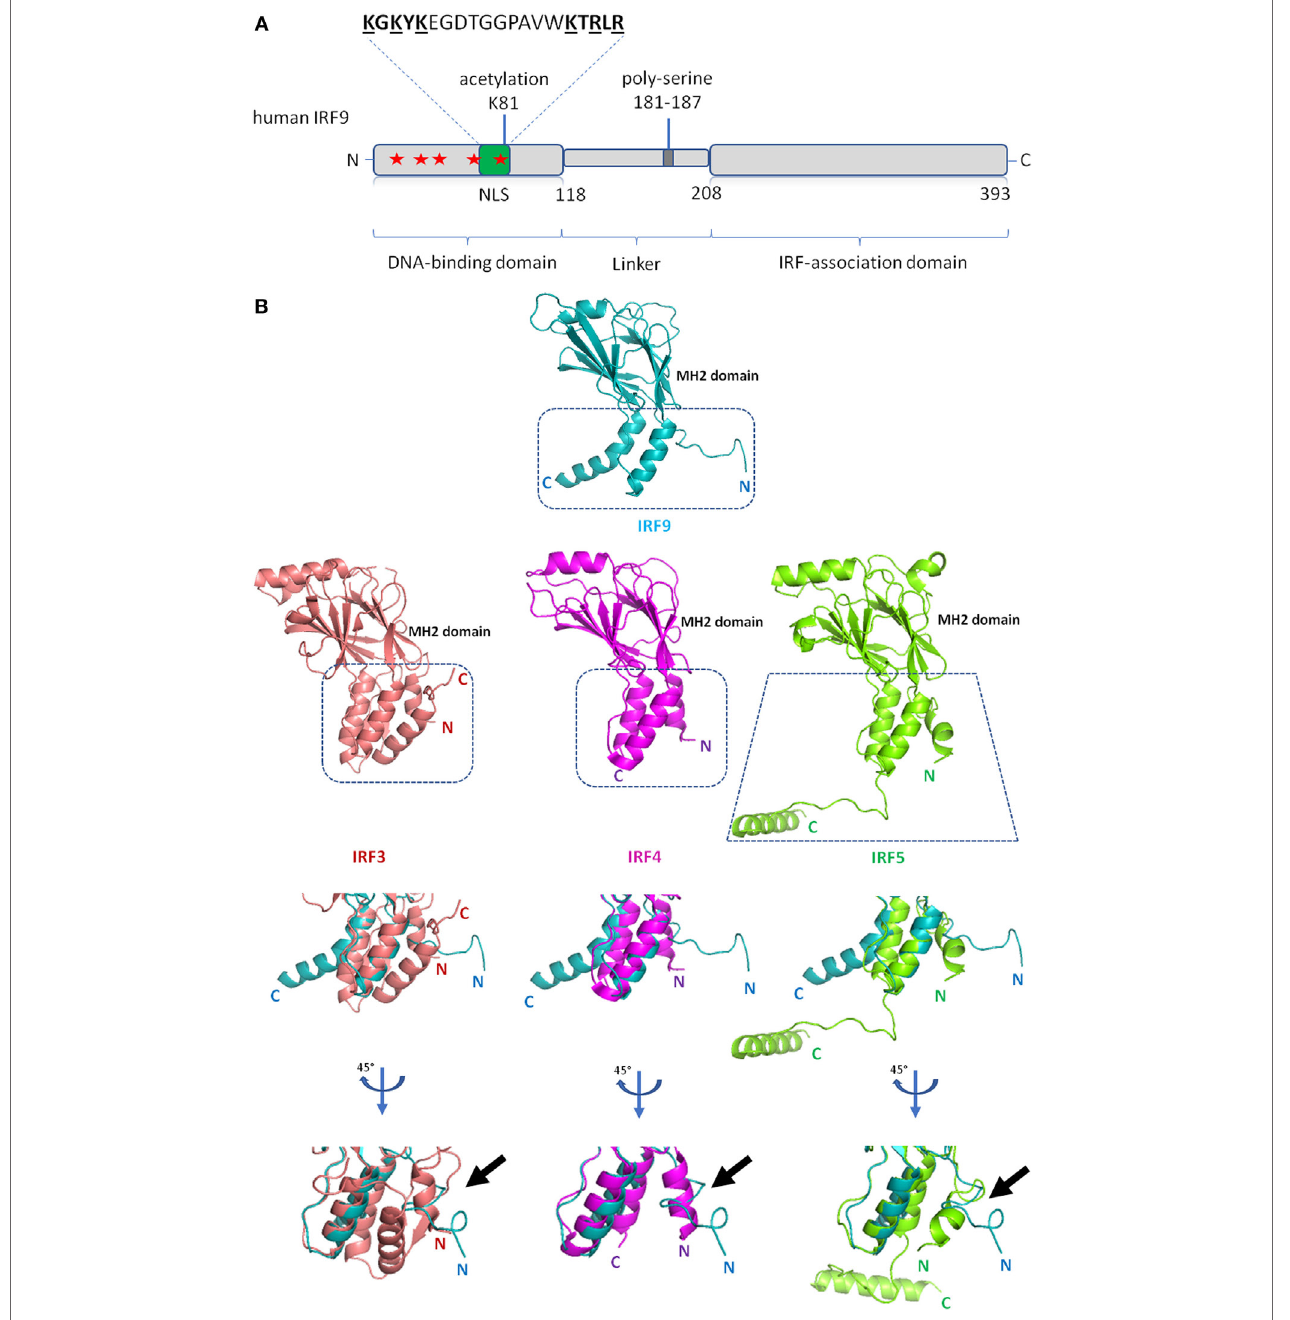
FiGURe 2 | Schematic diagram of interferon regulatory factor 9 (IRF9) and structure of IRF9 IRF-associated domain (IAD). (A) Domain organization of the full length human IRF9 shown in a schematic representation. The conserved tryptophan pentad (labeled red stars) of IRF9 are located at amino acid positions 15, 30, 42, 62, and 80 within the DNA-binding domain. Green box indicates the position (a.a. 66–85) of nuclear localization signal (NLS) of IRF9. The largely basic bipartite NLS is characterized as KGKYK separated by a spacer sequence of 10 amino acids followed by KTRLR (basic amino acids are shown underlined). (B) Crystal structures of the IAD of IRF9